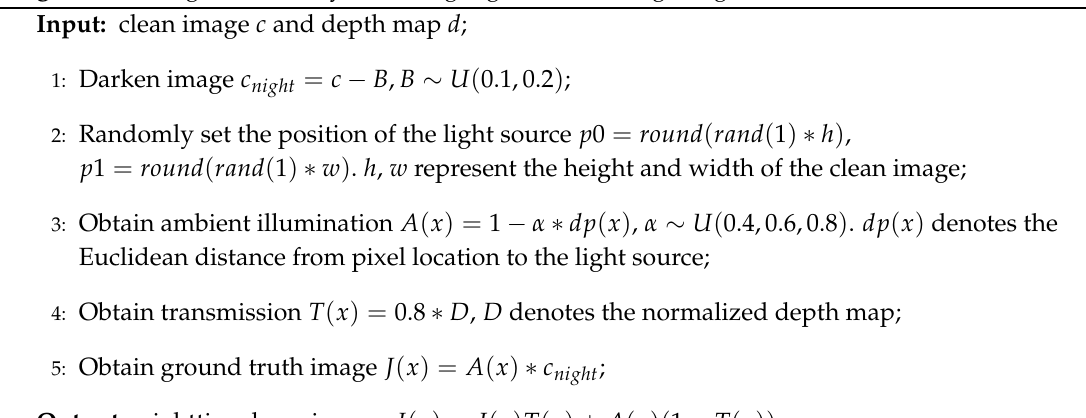
Algorithm 1: Algorithm for synthesizing nighttime training